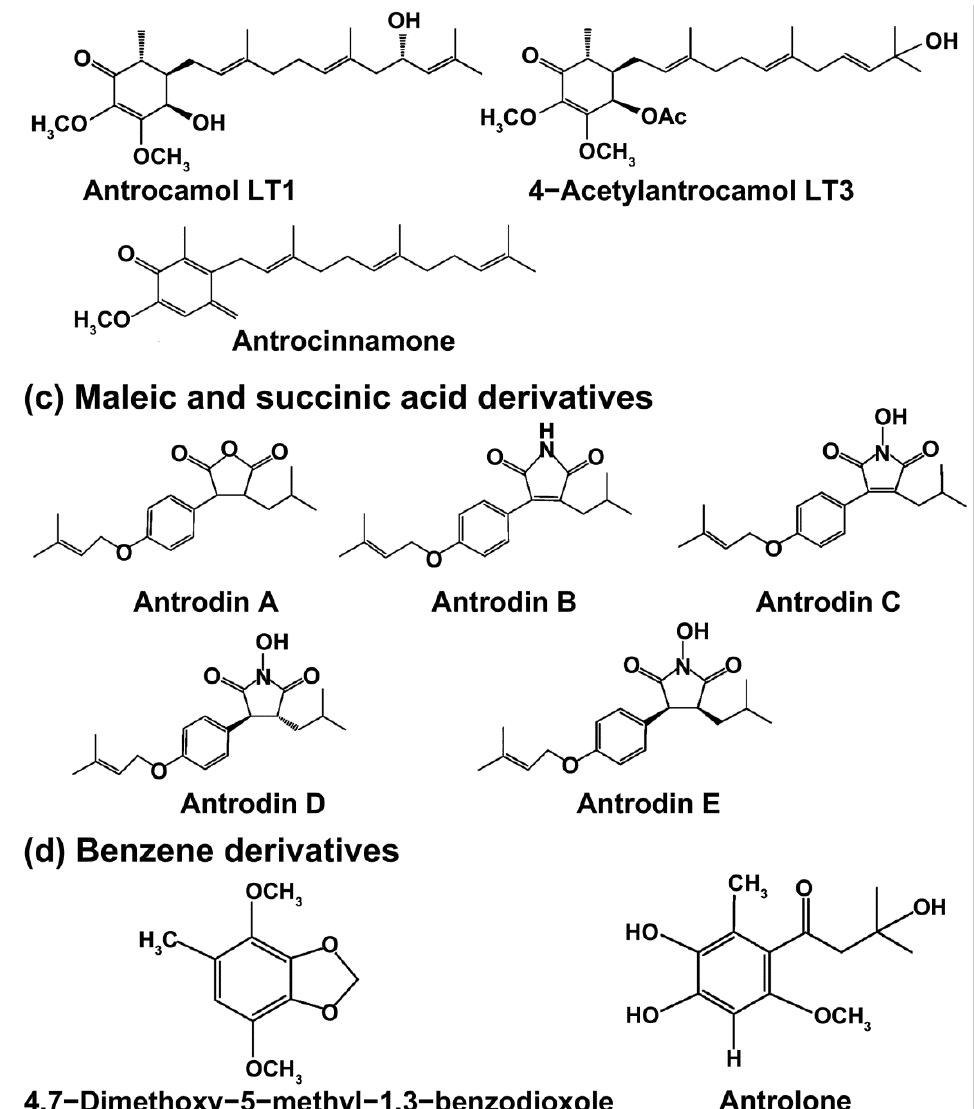
Figure 1. The chemical structures of the main bioactive components from Antrodia cinnamomea. ( a ) Triterpenoids, ( b ) ubiquinone derivatives, ( c ) maleic and succinic acid derivatives, ( d ) benzene derivatives.